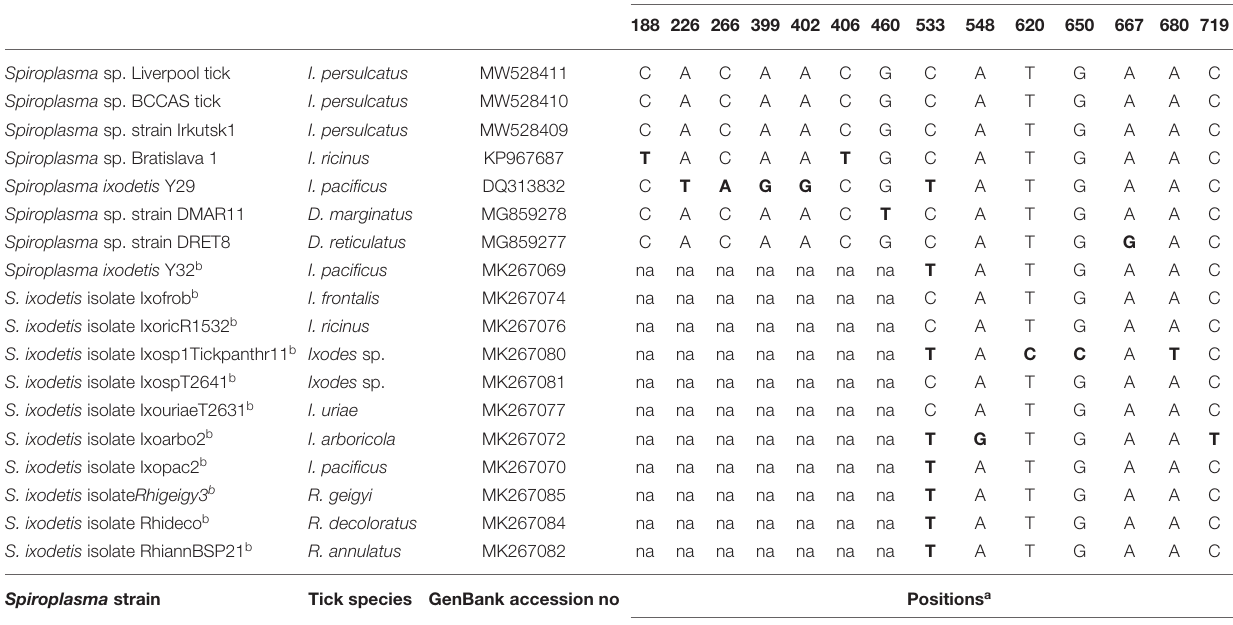
TABLE 2B | Polymorphisms in sequences detected in the Ixodes persulcatus -derived Spiroplasma sp. in this study compared to other tick-borne Spiroplasma spp. Spiroplasma